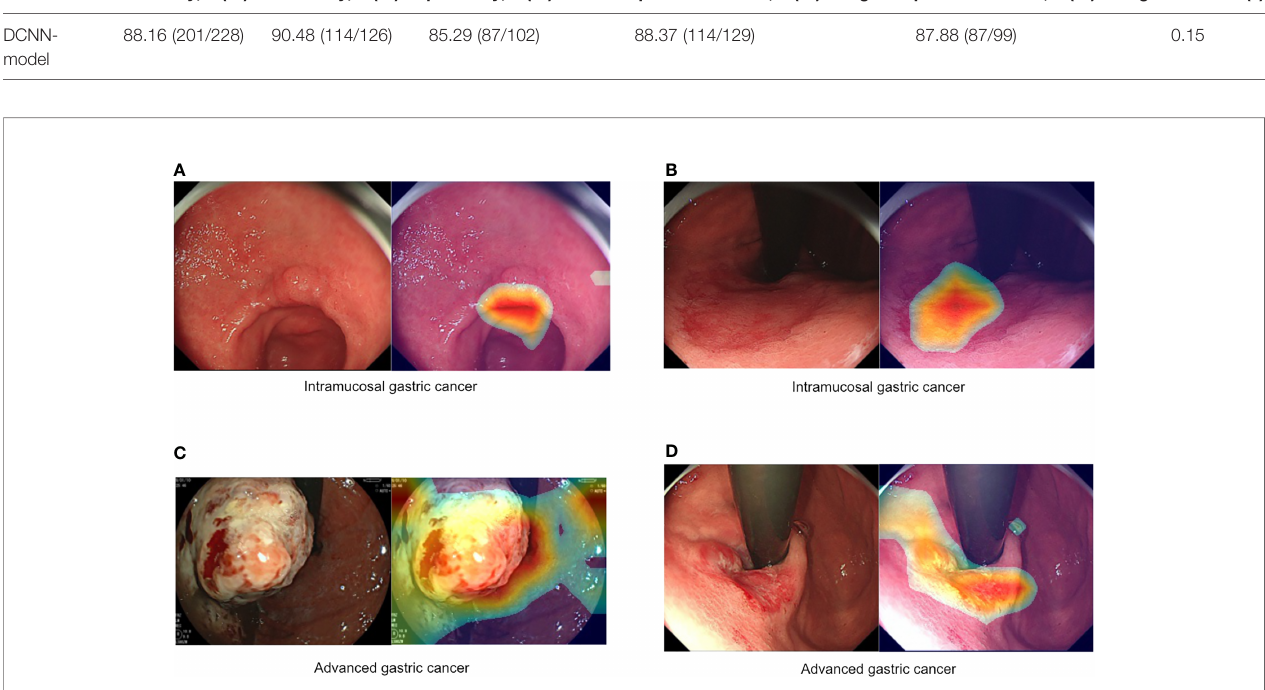
FIGURE 1 | Representative images of intramucosal and advanced gastric cancer. (A, B) Intramucosal gastric cancer, original c-WLI (left), and visual representation of the heatmap (right). (C, D) Advanced gastric cancer, original c-WLI (left), and visual representation of heatmap (right).